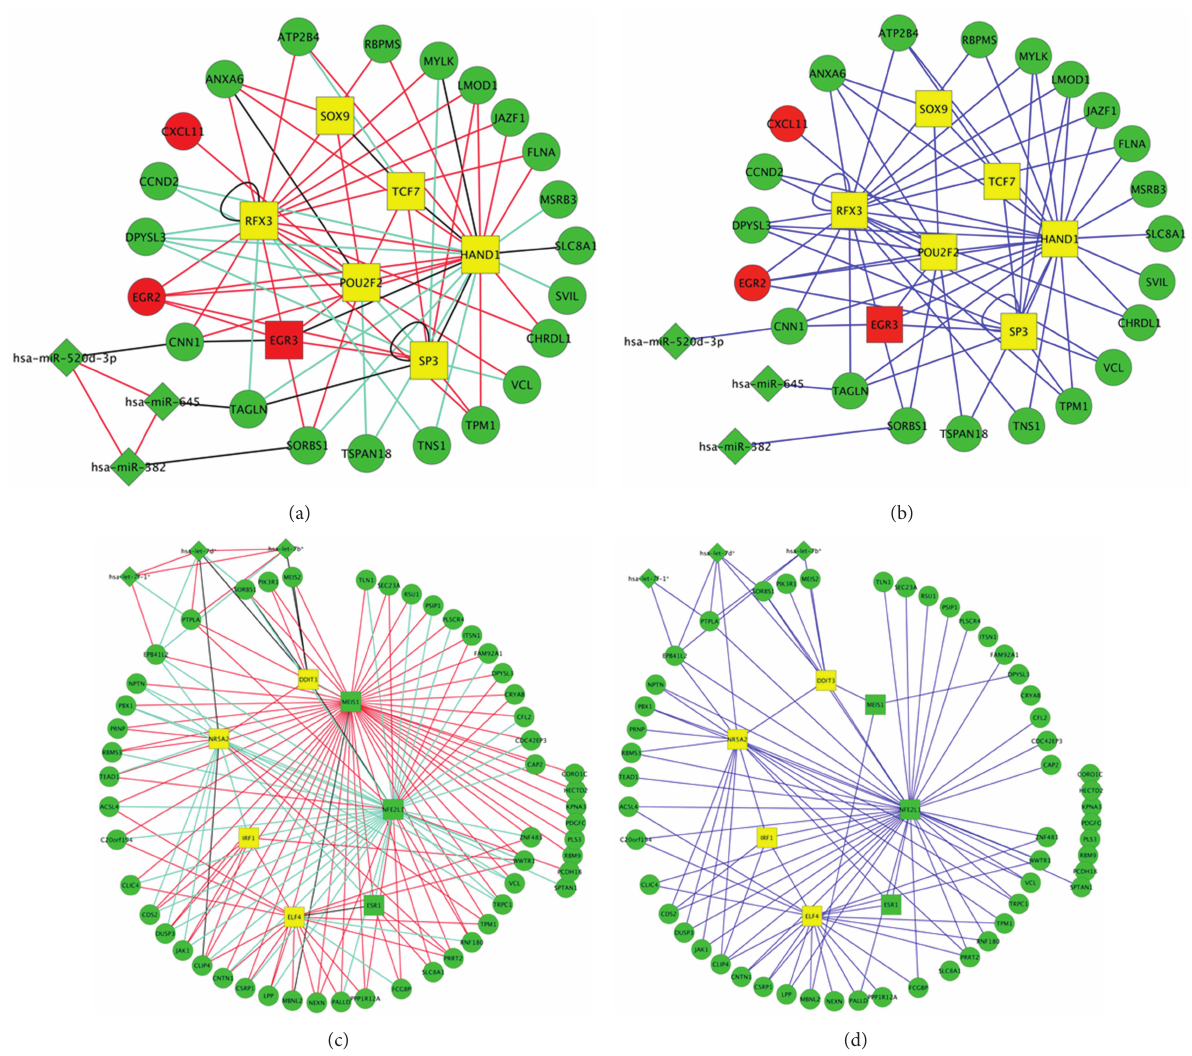
F 4: Two types of visualization of selected modules: (a) general representation of module 1; (b) sequence-based predictions only of module 1; (c) general representation of module 10; (d) sequence-based predictions only of module 10. Diamond, rectangle, and eclipse represent microRNA, TF genes, and nTF genes, respectively. Red nodes and green nodes represent overexpressed and underexpressed microRNAs/genes in tumor samples. Red lines and light green lines stand for positive correlations and negative correlations, respectively, while interactions that were predicted only by sequence information are drawn as black lines. For clear visualization, the links between nTF genes were not